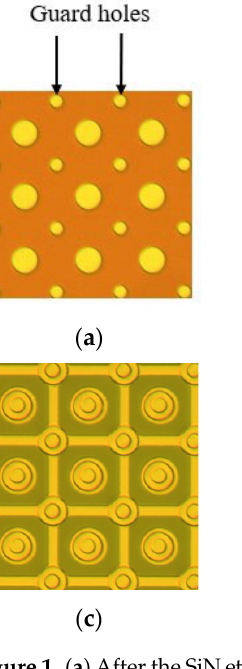
Figure 1. ( a ) After the SiN etching of the guard-hole structure. ( b ) After the SiN etching of the guard-ring structure. ( c ) After the P-metal deposition of the guard-hole structure. ( d ) After the P-metal deposition of the guard-ring structure.